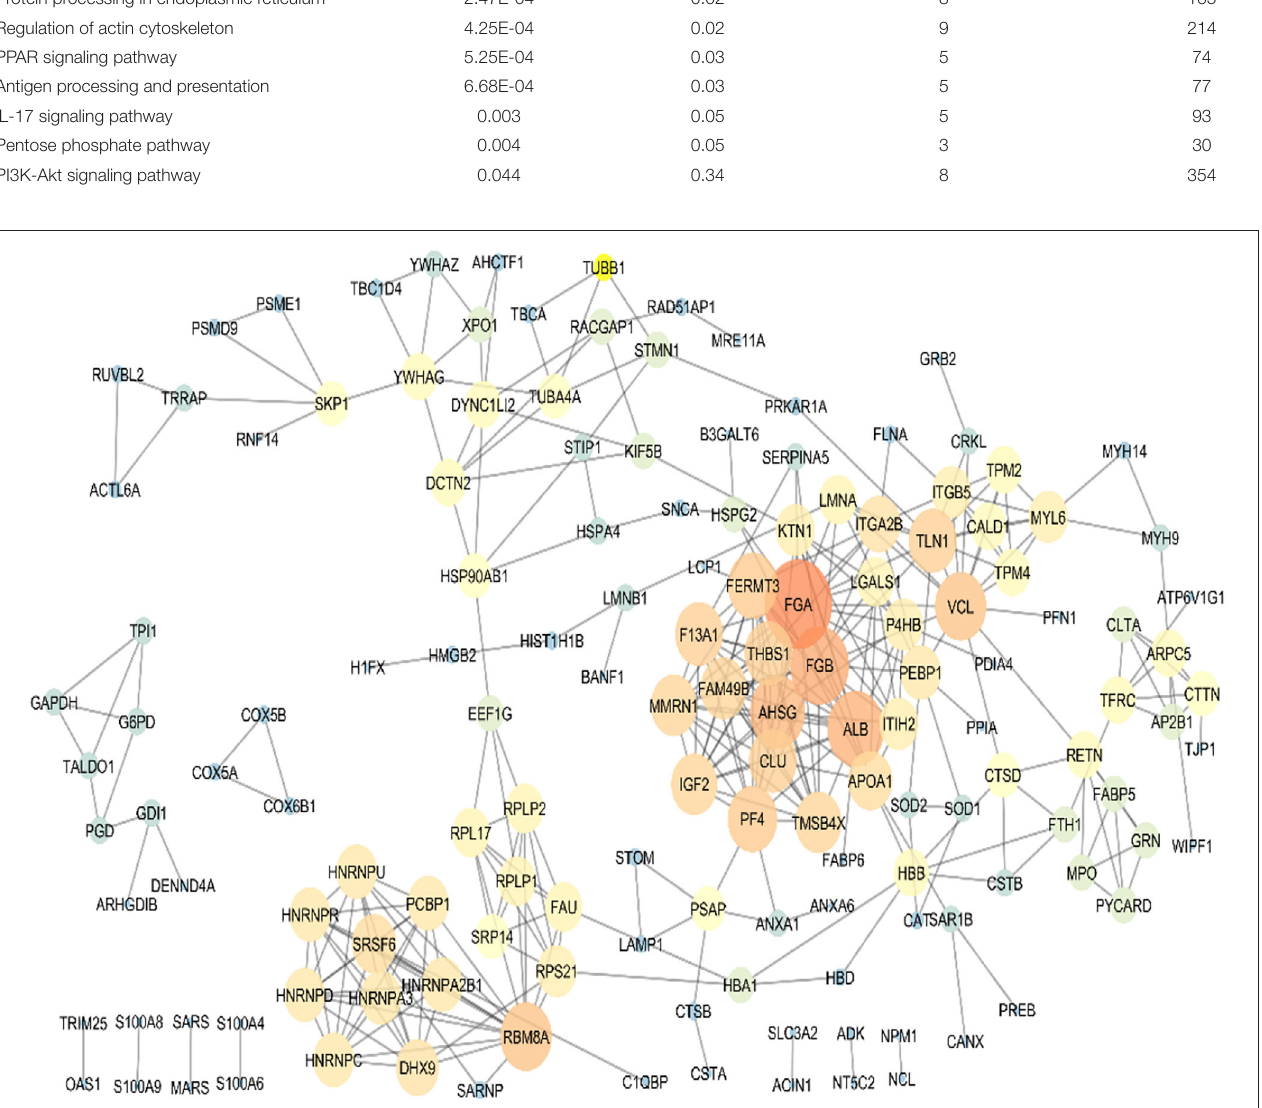
FIGURE 4 | Protein–protein interaction map of the differentially expressed proteins in the co-cultured PBMCs vs. PBMCs alone. Major hubs were highlighted. TMSB4X, SRSF6, and THBS1 are represented as significant signature based on the high connectivity degree value in the human protein–protein interaction networks.